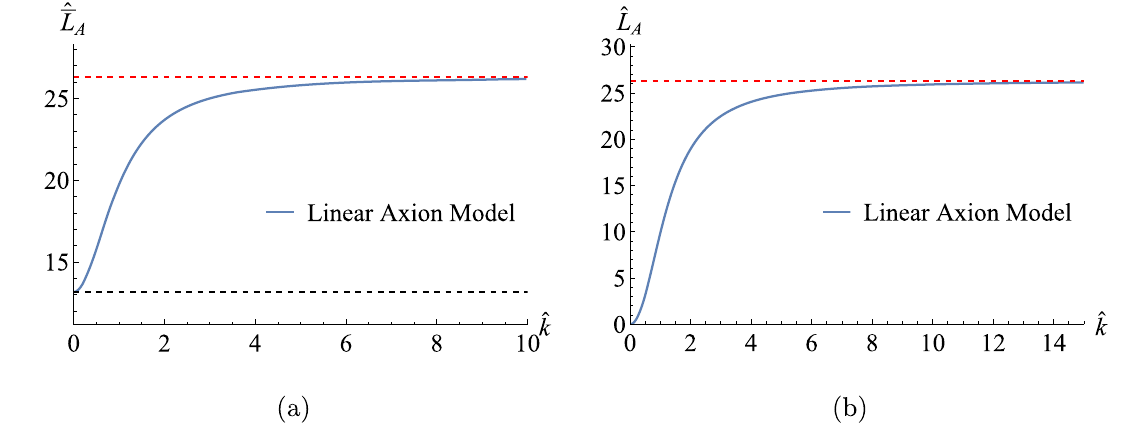
ˆ¯ L A as a function of ˆ k in the zero temperature limit for the typical linear axions model. The red dashed line Fig. 6 The Lorentz ratios ˆ L A and indicates the upper bound given by the limit ˆ k (cid:10) 1, while the black dashed line represents the lower bound set by the limit ˆ k (cid:9) 1